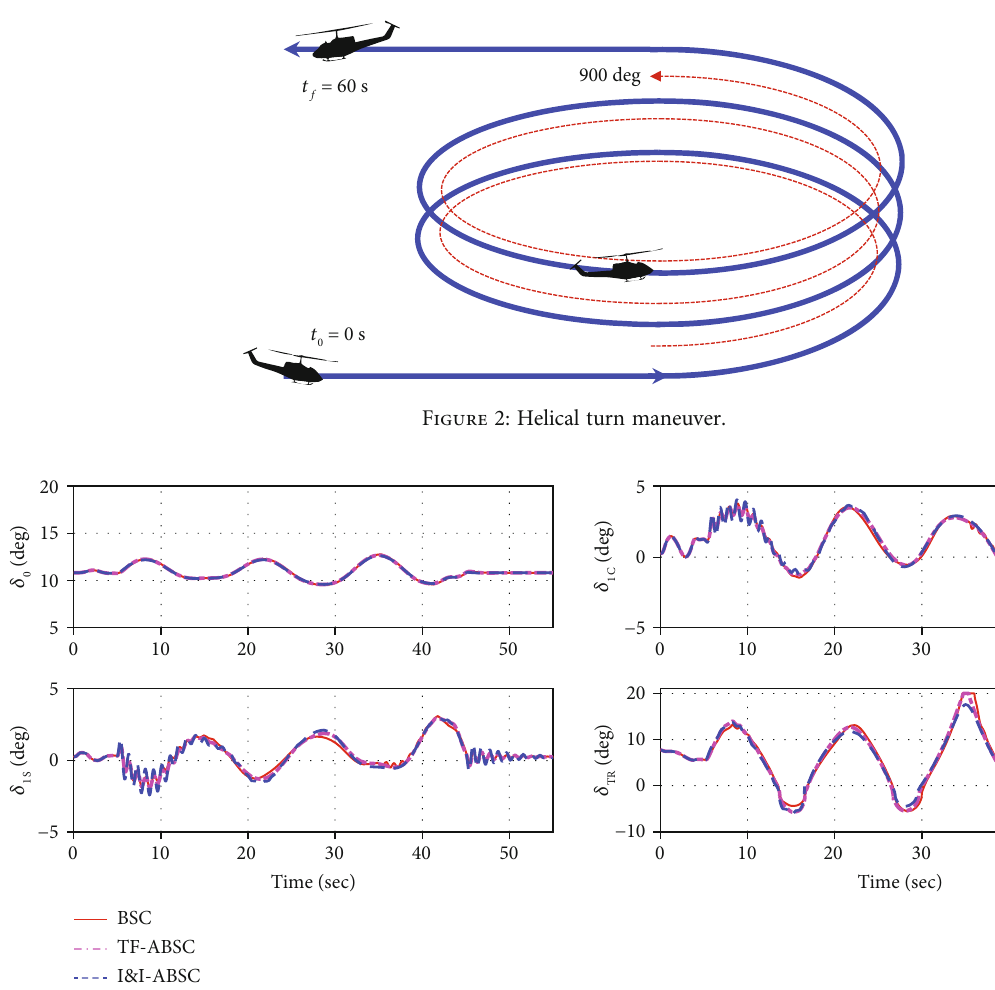
Figure 3: Case A: calculated controls of BSC, TF-ABSC, and I&I-ABSC.